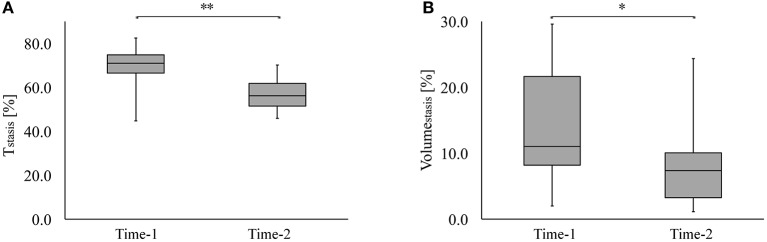
(A) The duration of stasis as a percentage of the cardiac cycle (Tstasis) and (B) the volume of stasis (Volumestasis) as a percentage of LA volume during Time-1 and Time-2. ** Shows that p < 0.005 and * shows that p < 0.05.